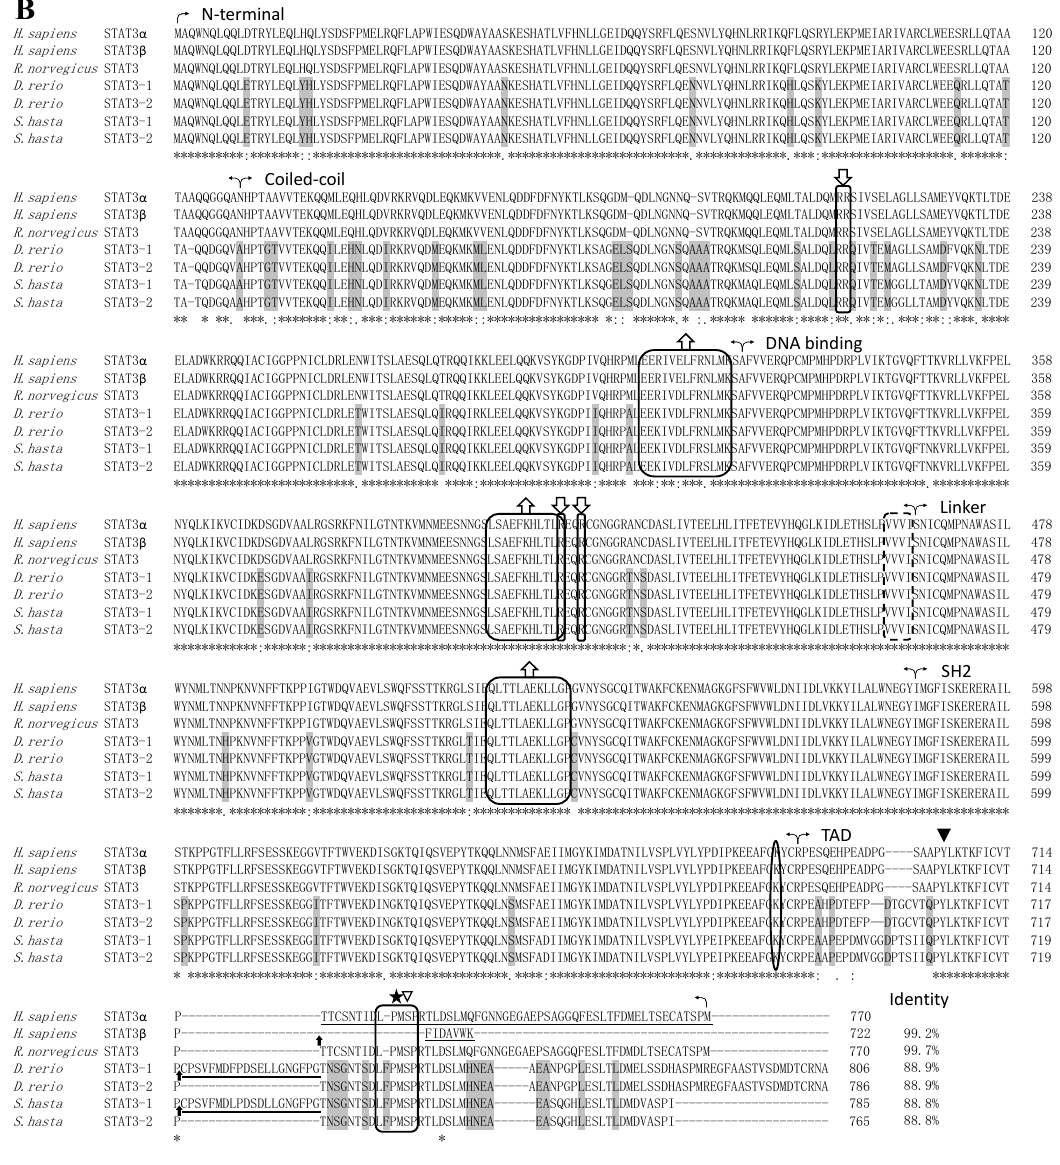
Figure 2. Cont. Figure 2.